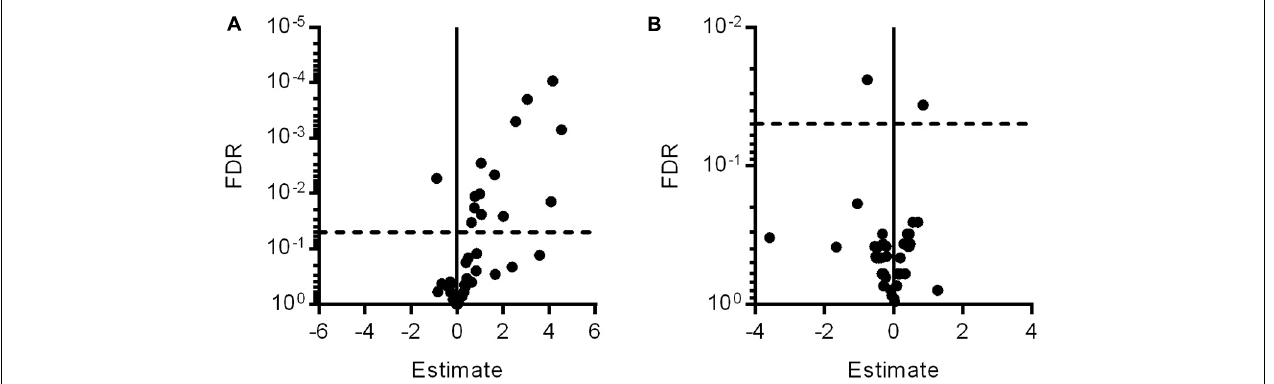
FIGURE 3 | Gene expression changes after clodronate treatment in PKD rats. With microfluidic cards, the expression levels of 44 selected genes associated with retinal inflammation and vasoregression were analyzed. (A) Of the 44 specific genes measured, 13 genes were upregulated and one gene was downregulated in PKD rats compared to SD rats. (B) After clodronate injection, C1s was upregulated and Fgf2 downregulated compared to PKD rats, with only Fgf2 being regulated in PKD compared to SD rats. Horizontal dashed lines at FDR = 0.05 indicate the level of